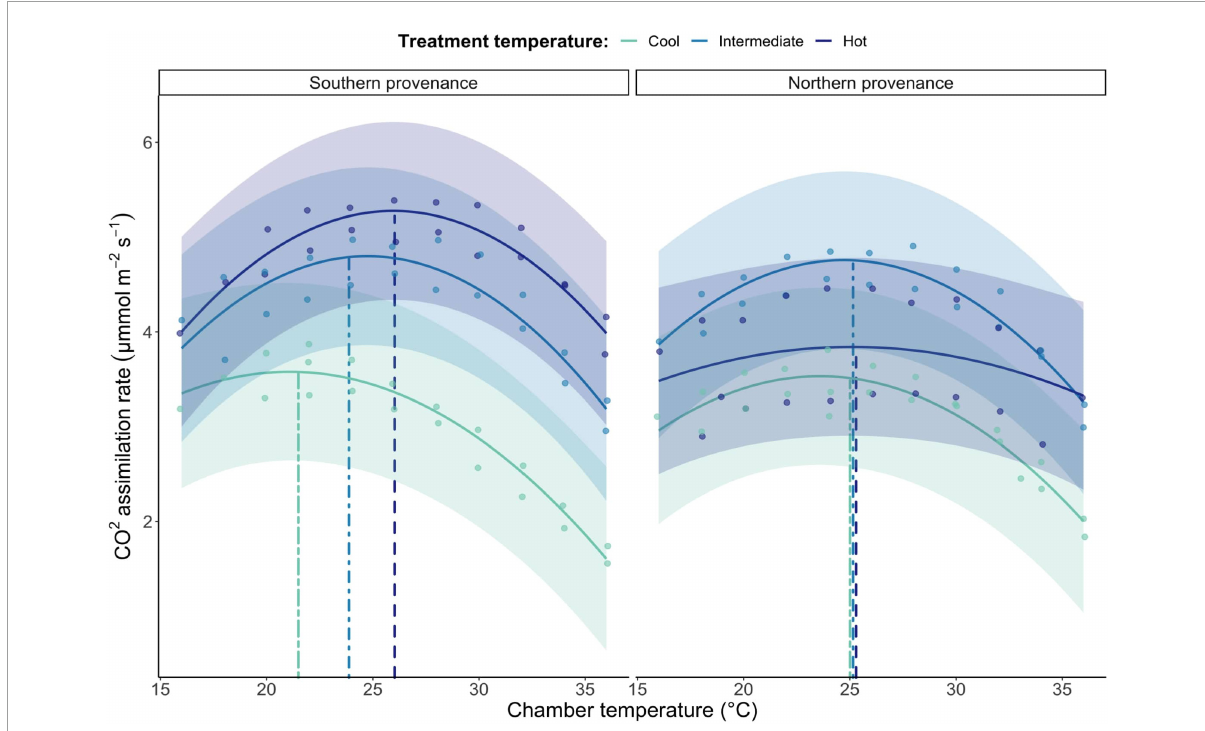
FIGURE3 Seedling temperature response curves separated by provenance location and average temperature treatment level. The colored bands represent 95% confidence intervals. Vertical lines represent photosynthetic optimum temperatures for each treatment group. Grouped vertical lines indicate a shared photosynthetic optimum temperature associated with the rightmost